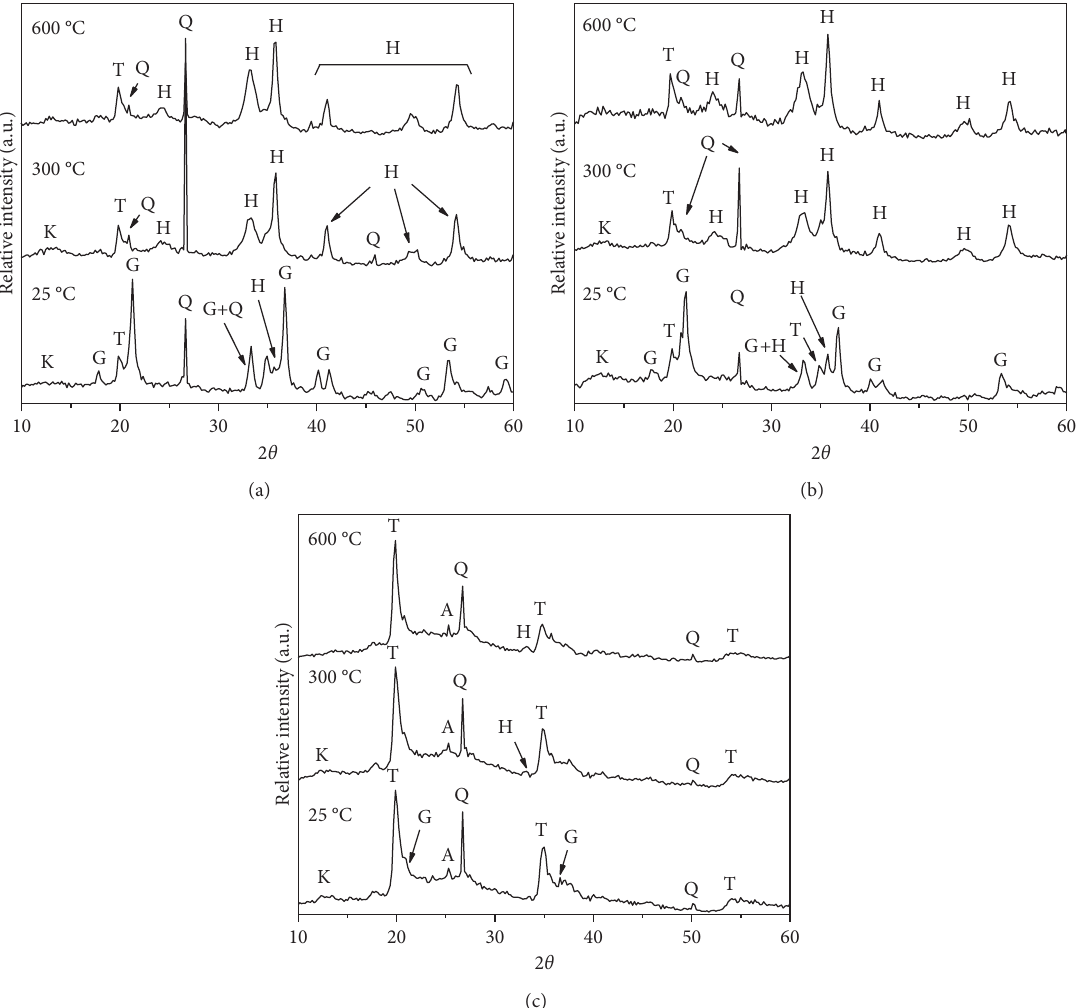
Figure 3: XRD patterns for the powders after the dissolution of calcium carbonate of the three types of limestones (a) biomicrite (BC-PAD), (b) biosparite (BS-PAD), and (c) intramicrite (IM-PAD) for thermal treatments of 25 ° C, 300 ° C, and 600 ° C. Reflection peaks are labeled as quartz (Q), goethite (G), hematite (H), tosudite (T), and kaolinite